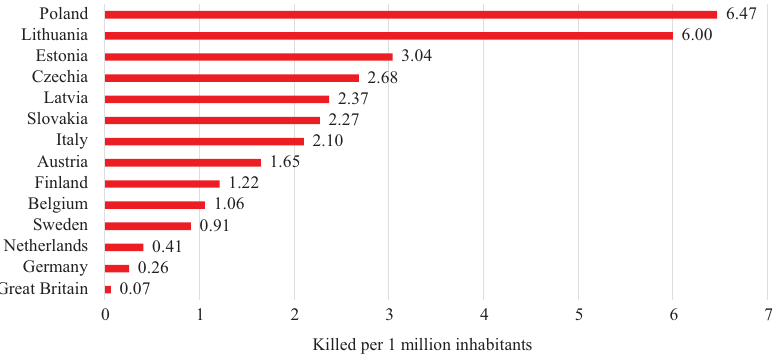
Figure 1. Road traffic death rate (number of people killed per 1 million inhabitants) at PCs